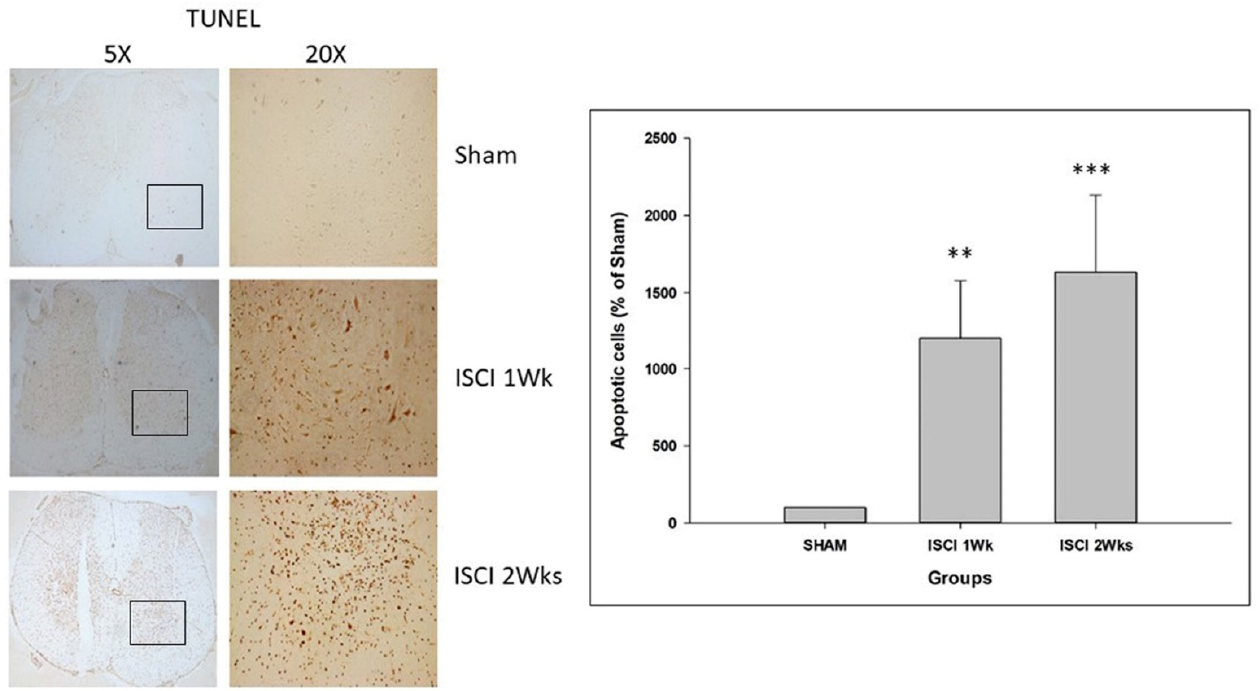
Figure 7. Immunohistochemistry images with the quantification results showing the TUNEL positive cells. Data are expressed as mean ± standard error. ** p < 0.01 versus the sham group; *** p < 0.001 versus the sham group.